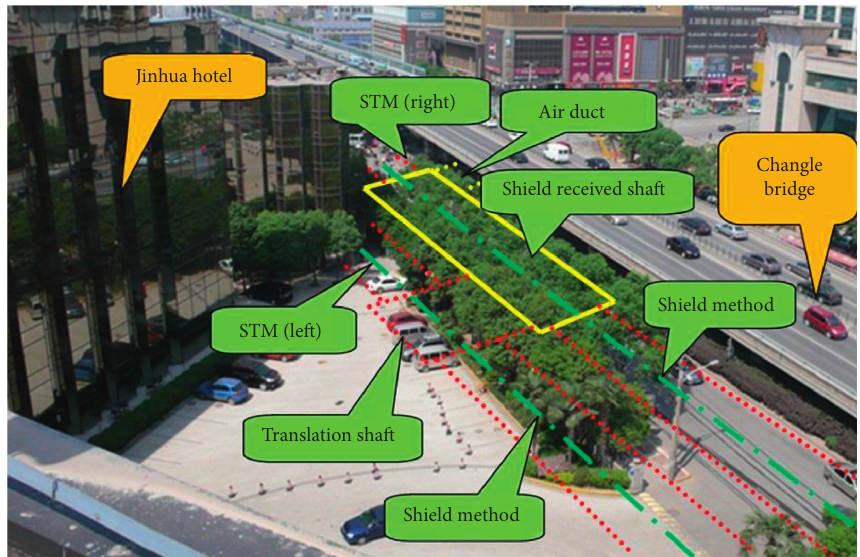
Figure 2: The relationship between the tunnel and the plane position of Jinhua Hotel building (image by authors).